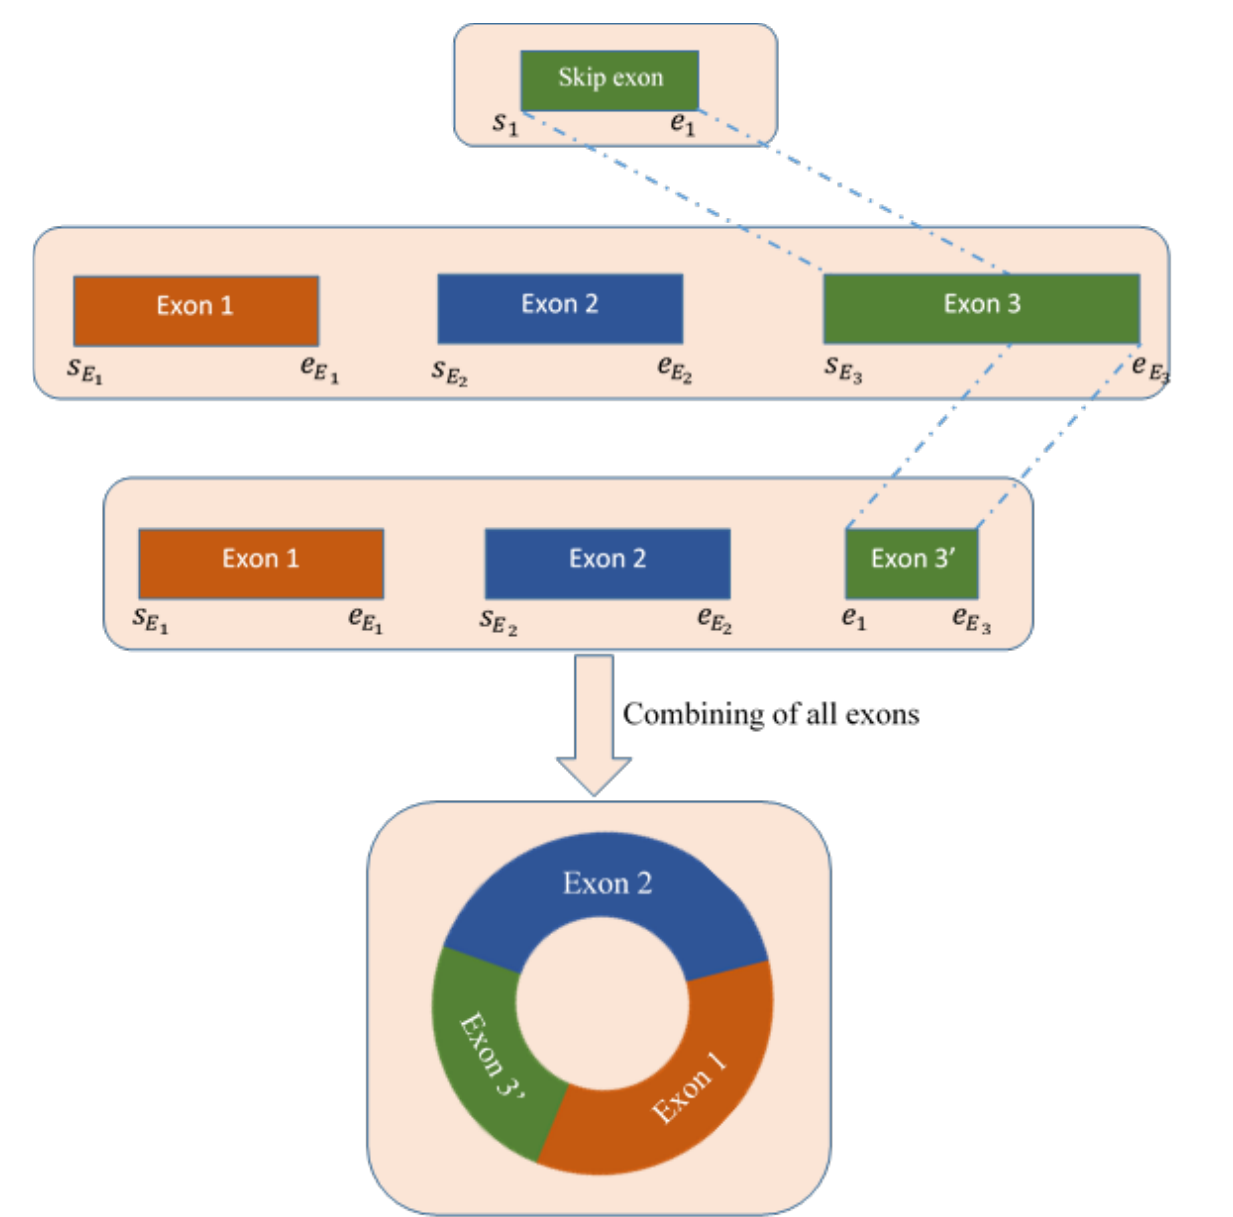
Figure 8. Procedure of deleting skip exon from all available exons extracted from the CIGAR string of the spanning chimeric